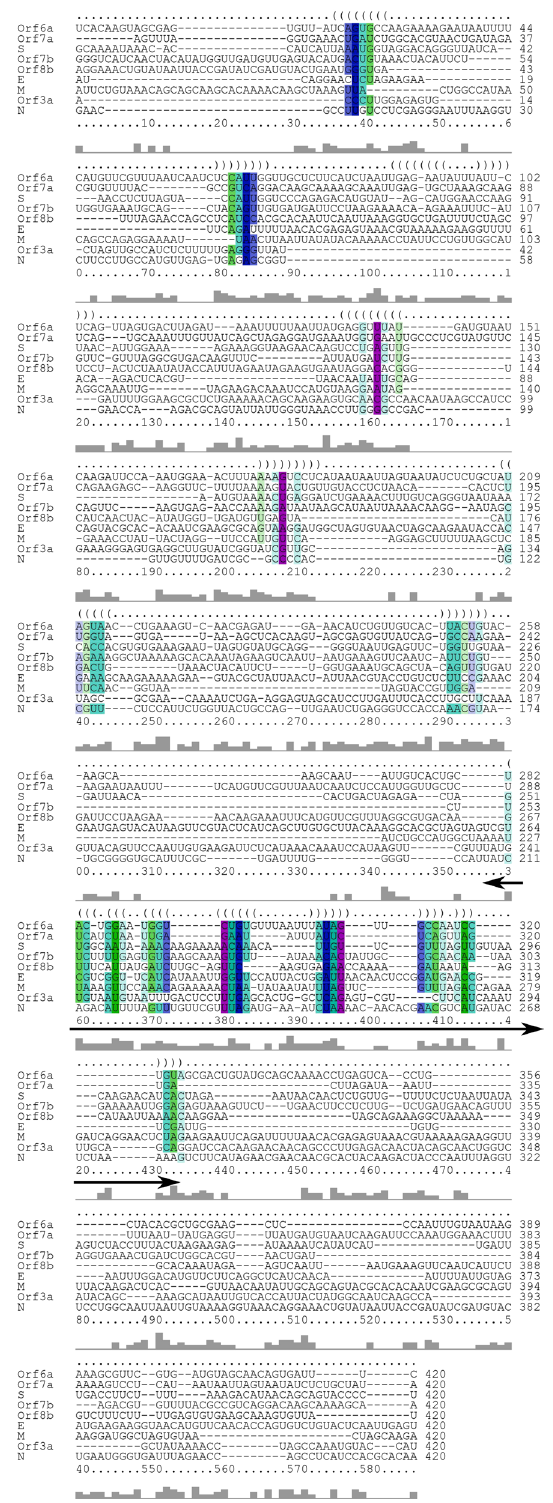
Fig. 1 The figure presents the output of alignment result of negative sense subgenomic RNAs of SARS-CoV-2 that was done through the LocARNA webserver. The alignment result revealed the consensus sequence and hairpin structure (with double headed arrow) among negative sense subgenomic RNAs. This consensus structure is present at the immediate downstream of initiation codon or TRS